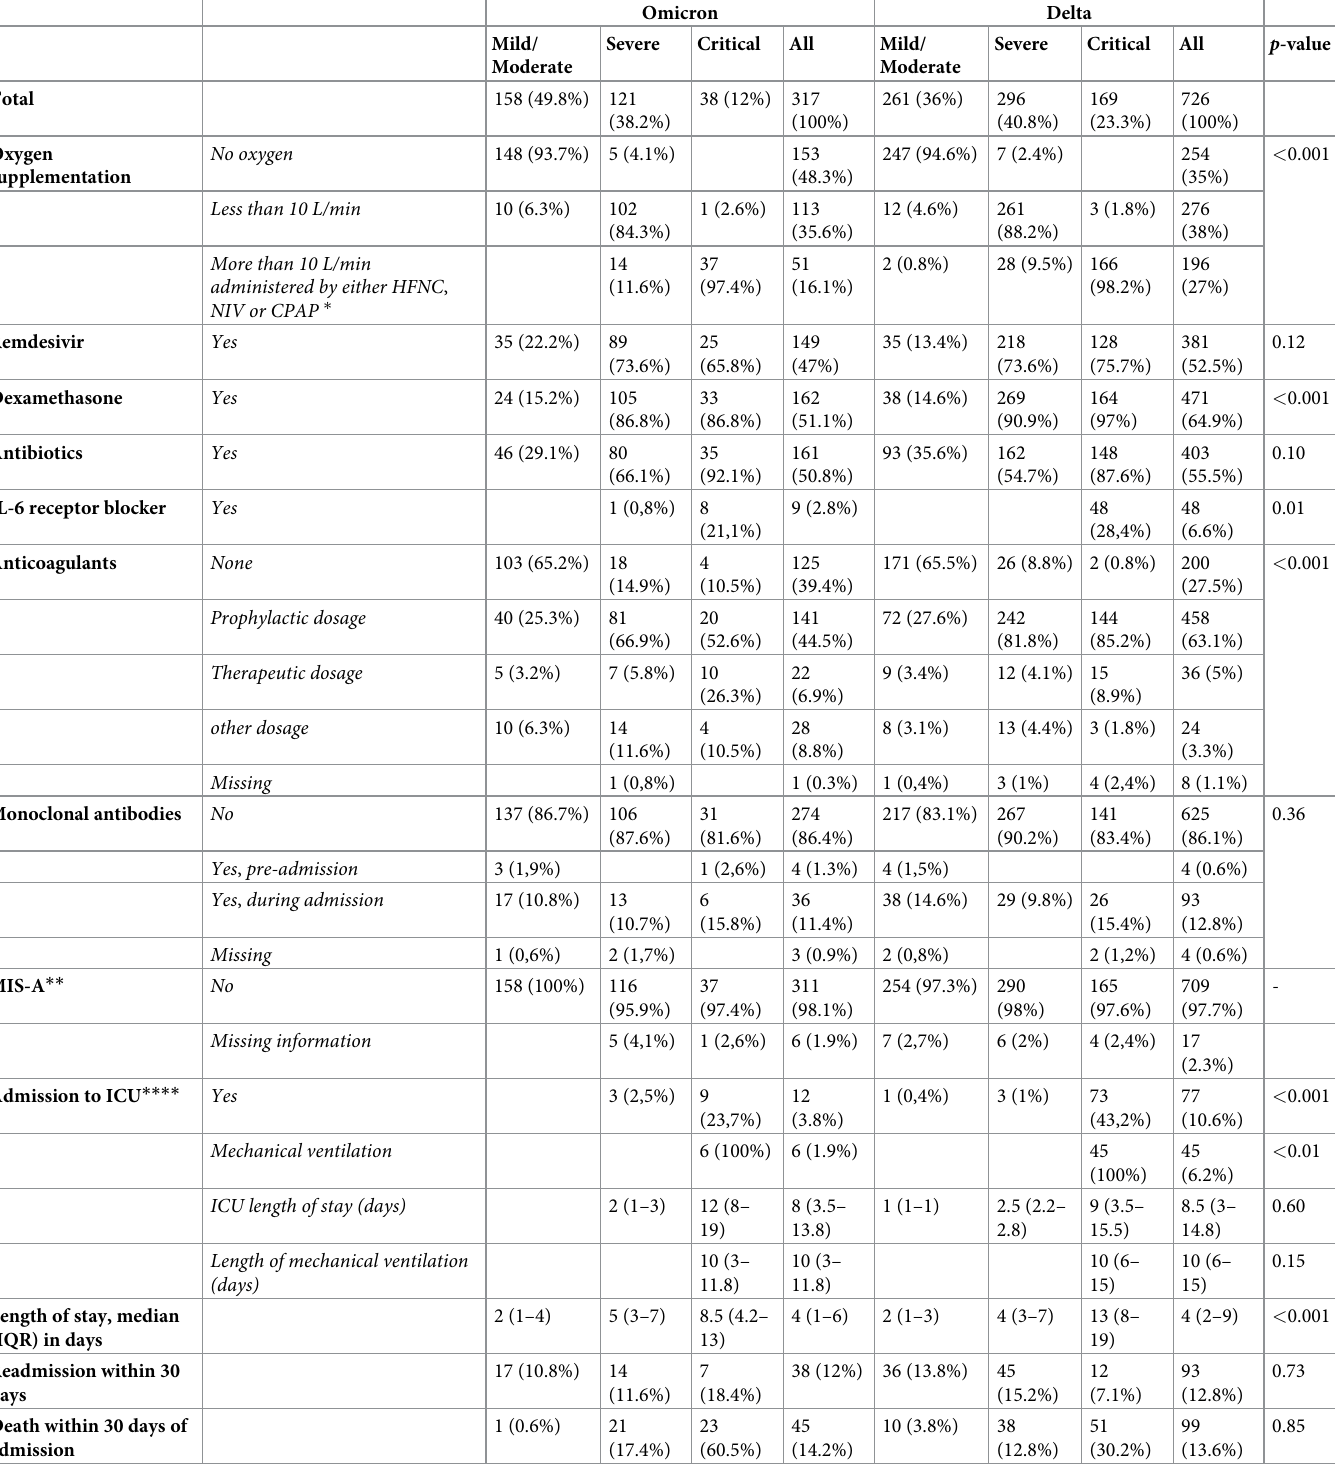
Table 3. Treatment, clinical outcomes and mortality of patients hospitalized with COVID-19 due to SARS-CoV-2 Omicron and Delta variants, according to disease severity (Copenhagen, 1 September 2021 to 11 February 2022; n =